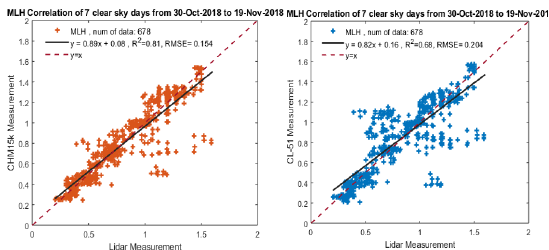
Figure 1. MLHs comparisons between lidar and ceilometers (a) CHM15k (b) CL51